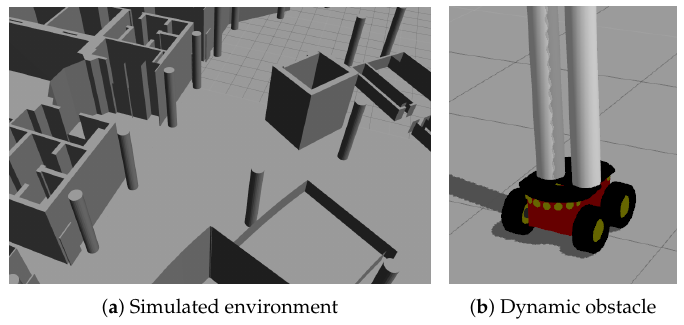
Figure 7. Simulated Test Bed and a robot simulating a person.